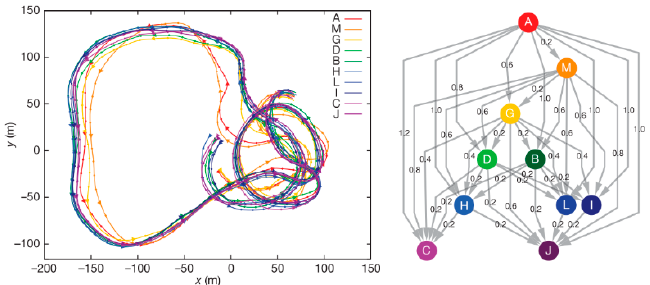
Figure 22. Hierarchical leadership network [63].